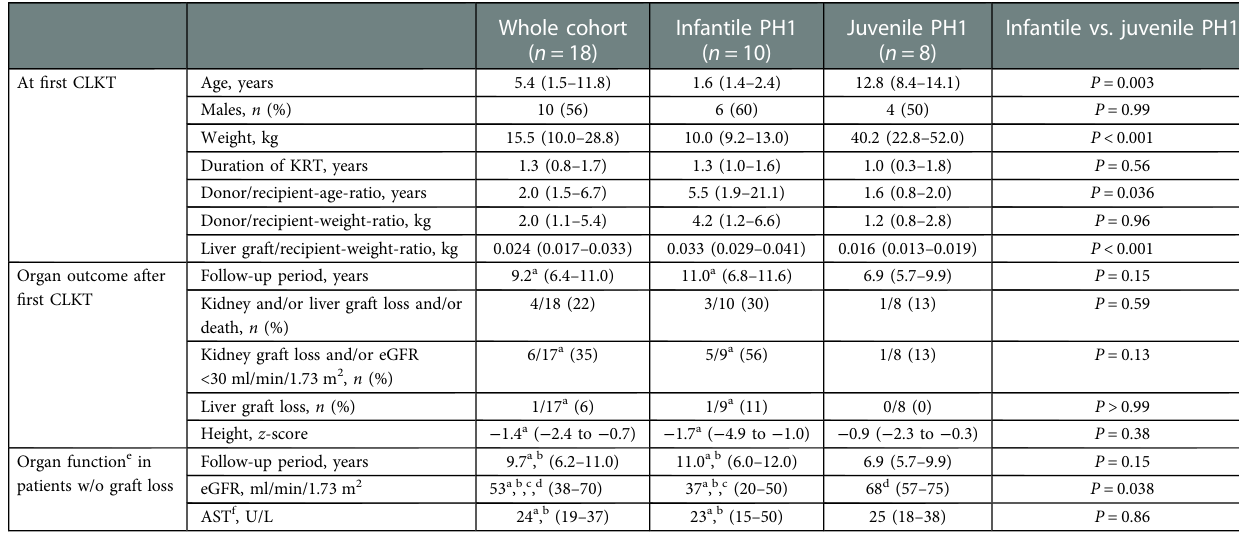
TABLE 1 Clinical data (median, IQR) of 18 patients with PH1.